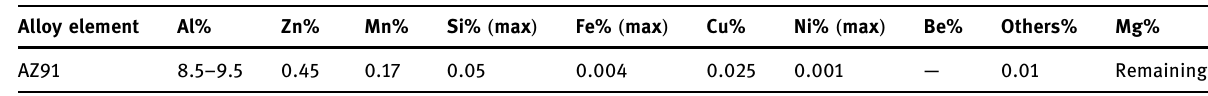
Table 1: AZ91 magnesium alloy and its chemical composition ( wt% ) [ 27 ]